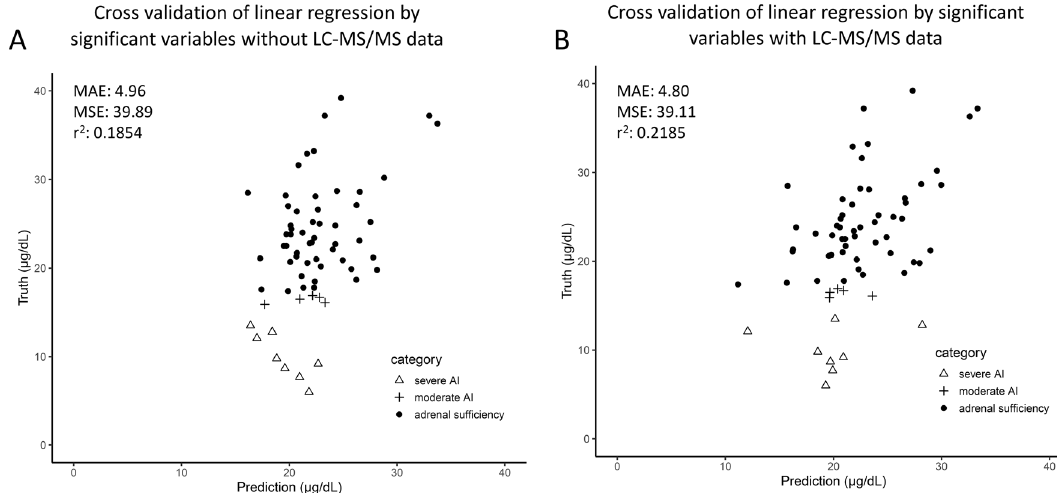
Figure 3. Plot of the true value and predicted value by linear regression model without ( A ) and with ( B ) LC– MS/MS in cross